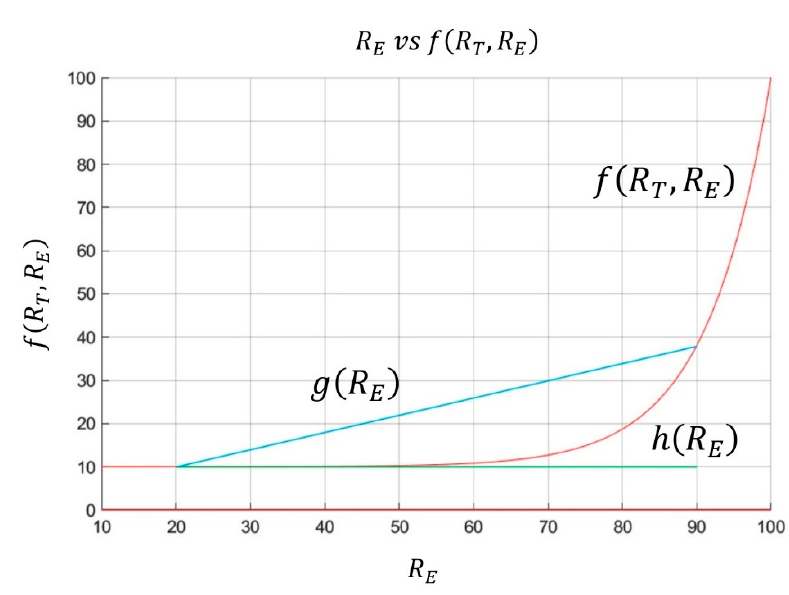
Figure 12. Expert Risk vs. Decision Factor.